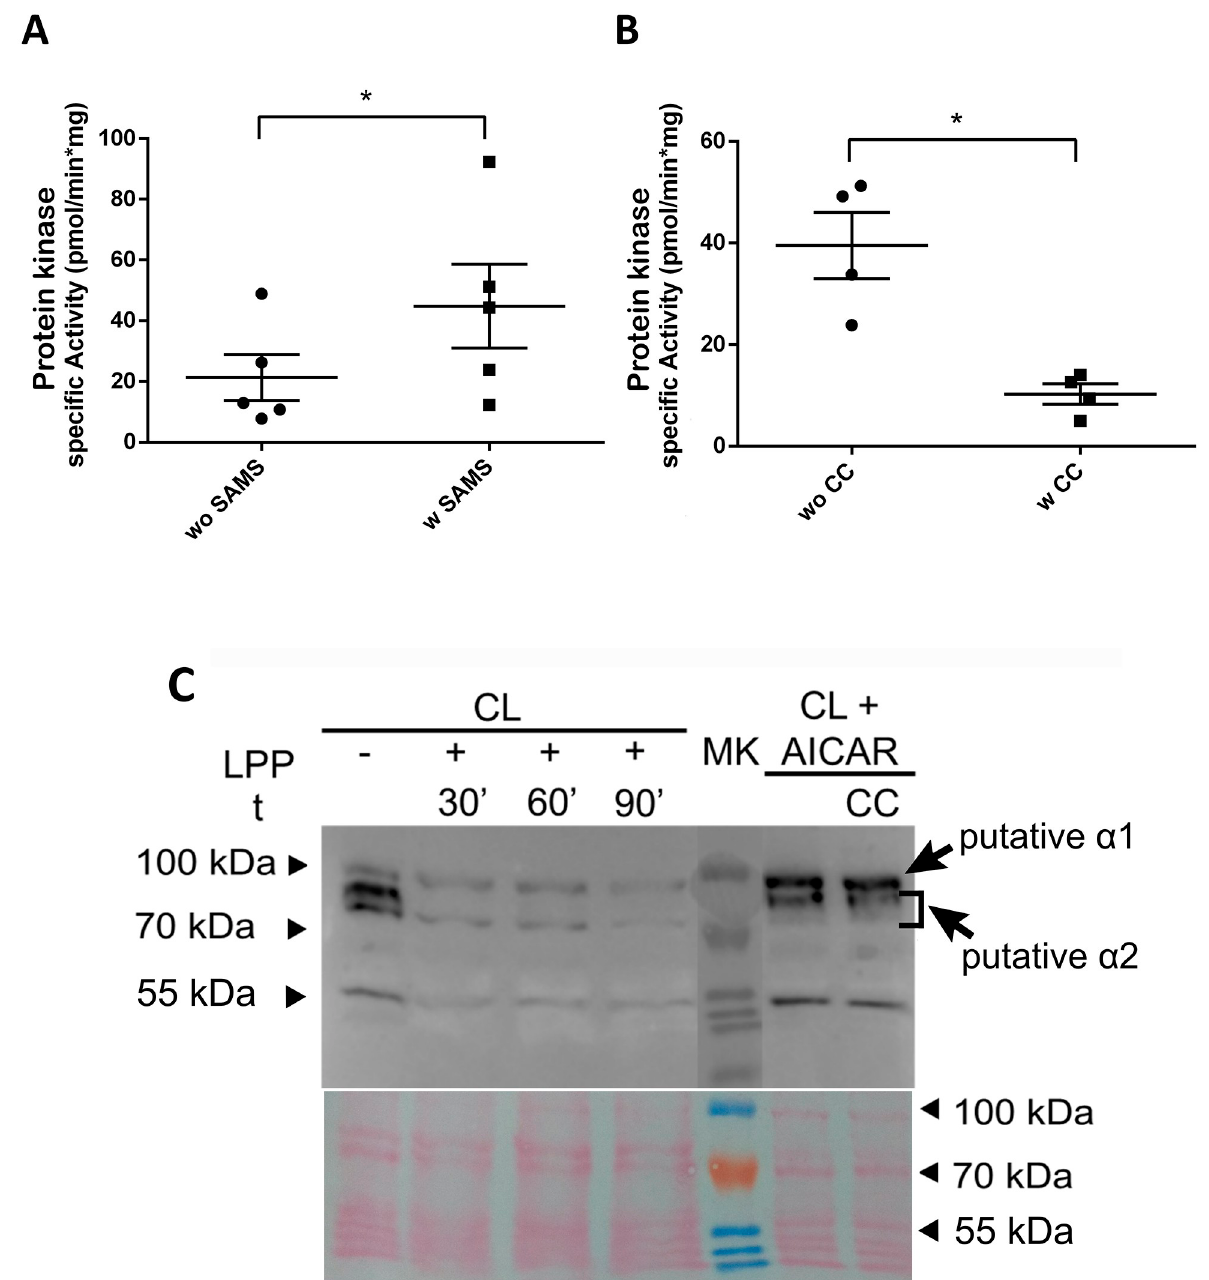
Fig 3. Kinase activity assays and detection of AMPK α subunit phosphorylation confirm T . cruzi epimastigotes express a functional AMPK. ( A ) Epimastigote whole protein extracts were tested for AMPK substrate, SAMS, phosphorylation by incorporation of 32 P. Results show a significant increase in activity when SAMS is added to the mix (n = 5). ( B ) Addition of Compound C, an AMPK inhibitor, to the activity mix decreases activity to basal levels (n = 4). ( C ) Phosphorylation of the activation loop of AMPK α subunits was tested with Phospho-AMPK α (Thr172) antibody. Two bands of the expected weights for both TcAMPK α subunits were revealed. Lambda Phage Phosphatase treatment eliminated or reduced these markings. AICAR treatment, a specific AMPK activator, of epimastigotes cultures modified the intensities of the two bands. This effect was not altered by CC simultaneous treatment. All lanes contain equal mass of protein extract. Arrowheads indicate the position of the 55, 70 and 100 kDa marker bands. Bottom panel shows the Ponceau staining as loading control. Representative assay from at least two experiments. CL: CL Brener epimastigote protein extract; LPP: Lambda Phage Phosphatase; MK: molecular weight marker; CC: Compound C; t: time. Error bars represent Standard Error of the Mean. Statistical test corresponds to paired t-test. � p value < 0.05.